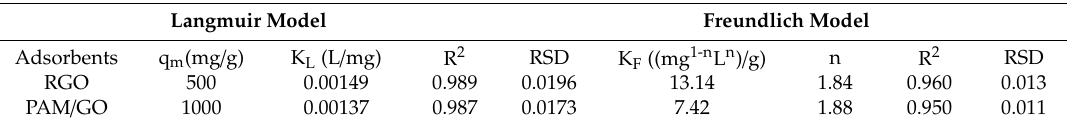
Table 2. Langmuir and Freundlich adsorption results for Pb(II) onto the surface of RGO and RGO / PAM composite